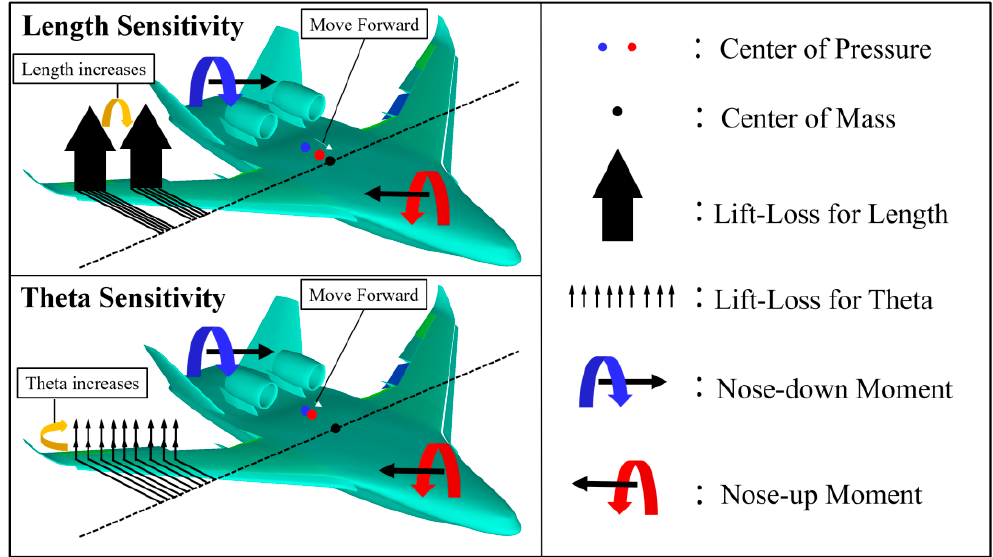
Figure 20. Arms of force of lift-loss in the sensitivity